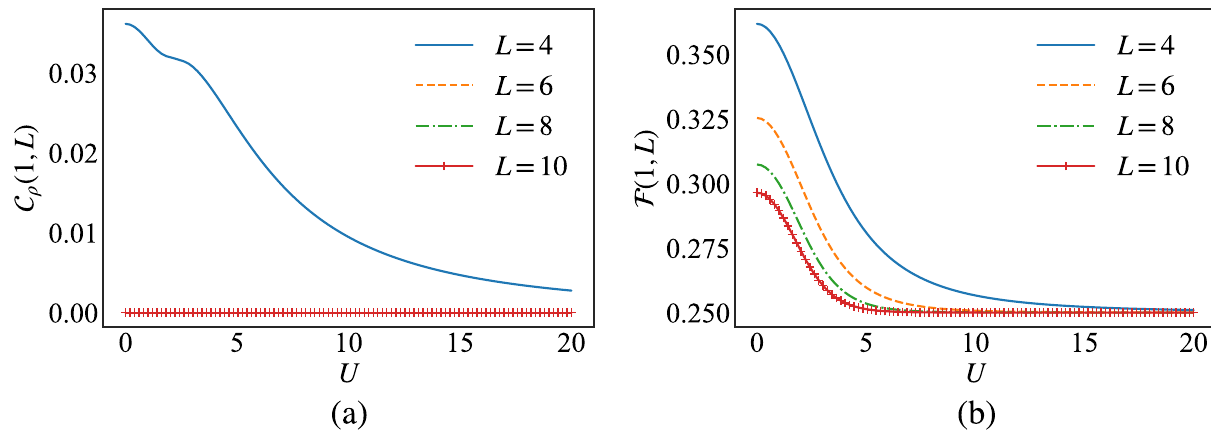
Figure 1. ( a ) The end-to-end concurrence, Eq. (13), and ( b ) the fidelity, Eq. (9), versus U in the Fermi– Hubbard model, Eq. (1), for several chain sizes L